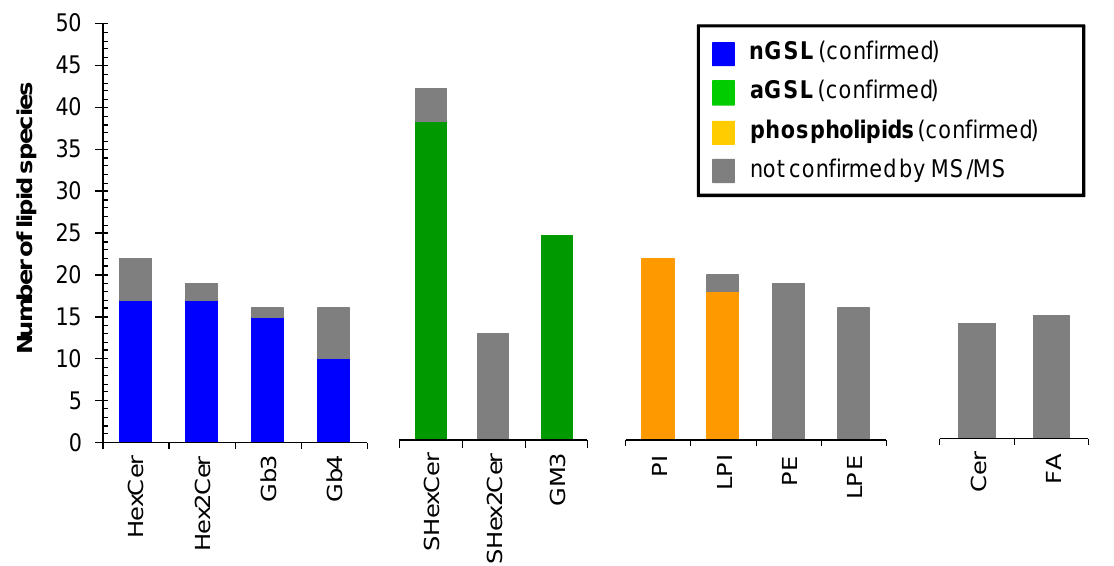
Figure 9. Number of lipid species identified within particular lipid subclass. Colored bars represent the number of lipid species identified and structurally characterized by MS/MS experiments. Grey bars correspond to identified lipid species that were not confirmed by MS/MS experiments. Abbreviations: neutral glycosphingolipids (nGSL) and acidic glycosphingolipids (aGSL).